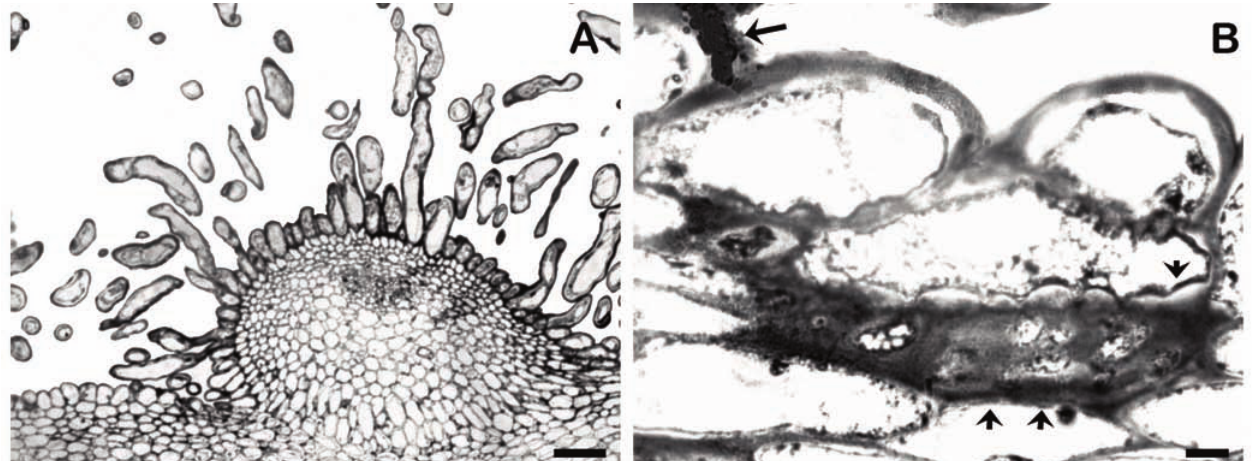
Fig. 4 - Nectary of Moringa oleifera Lam. (light micrographs). A, longitudinal section of the nectary; B, detail of the nectar cumulated in the intercellular spaces (arrows). Bars = A, 100 µm; B, 10 µm.